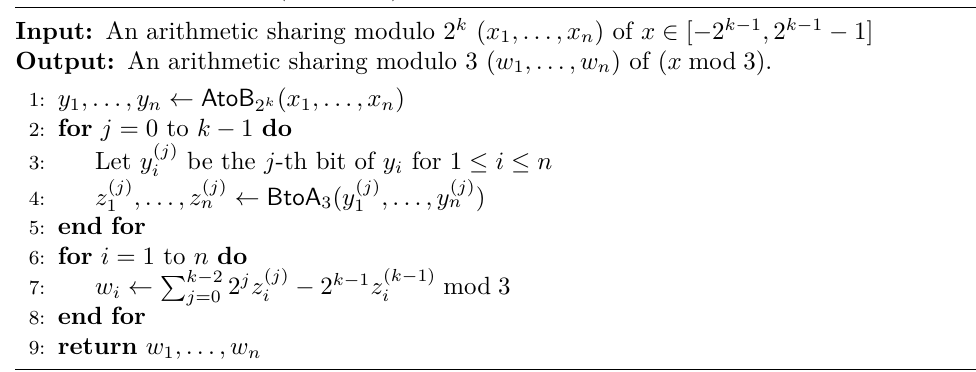
Algorithm 7 Mod3Red ( v 1 , . . . , v n